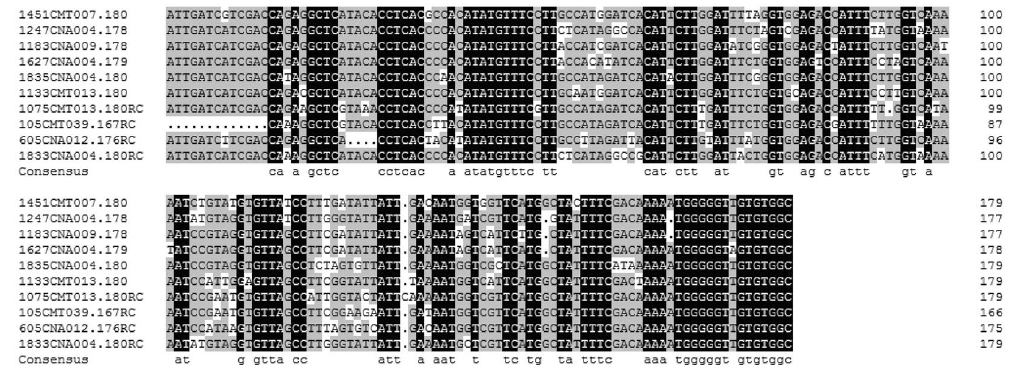
Figure 2. 180-bp knob sequences are highly variable. To determine the diversity of 180-bp knob sequences, the top ten fasta abundant sequences were aligned by DNAMAN 7.0. Sequence names reflect the assembled sequence number, the name of the inbred line, and the length of the knob. For example, 1833CNA004.180 is the 1833rd sequence of the inbred line CNA004 and is 180-bp long. The number to the right of each sequence indicates the length of the sequence. The last line shows the 180-bp knob consensus